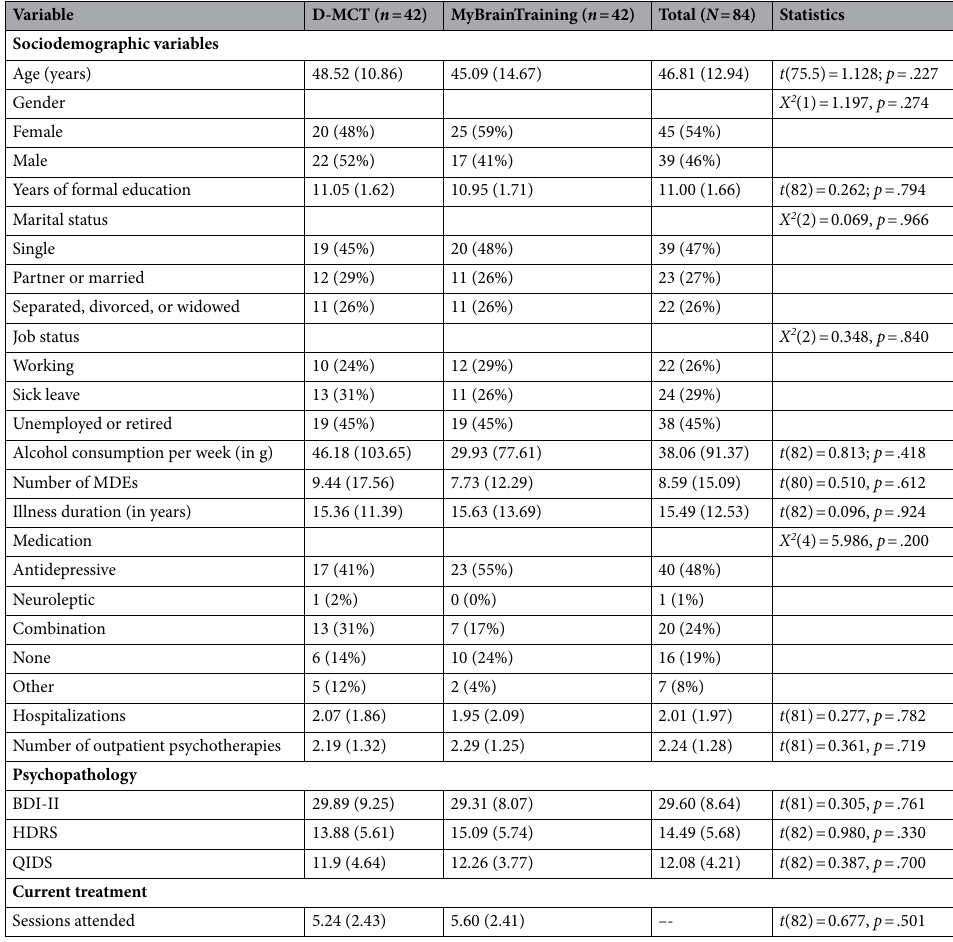
Table 1. Demographics: frequencies, means, and standard deviations (in brackets). MDE = major depressive episode, BDI-II = Beck Depression Inventory, HDRS = Hamilton Depression Rating Scale, QIDS = Quick Inventory of Depressive Symptomatology. Medication “other” is, for example, L-Thyroxin, St. John’s wort.